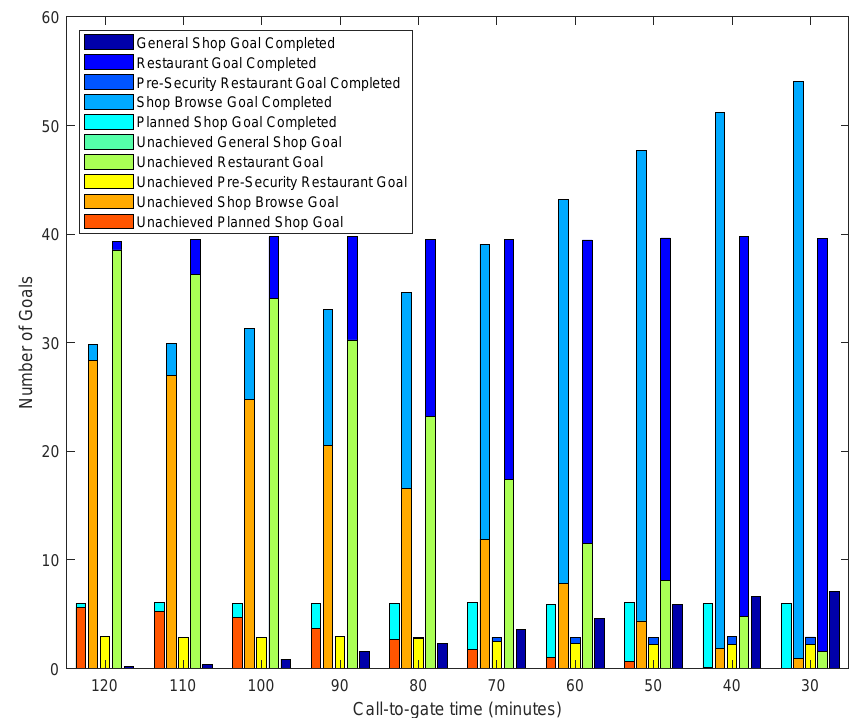
Figure 6. The impact of call-to-gate strategies on average number of generated passenger agent goals. The indicated number of goals represents the mean value of 1000 simulation runs for that call-to-gate time. The legend shows the distinction between completed and unachieved goals. Completed goals indicate that the passenger agents has interacted with the discretionary